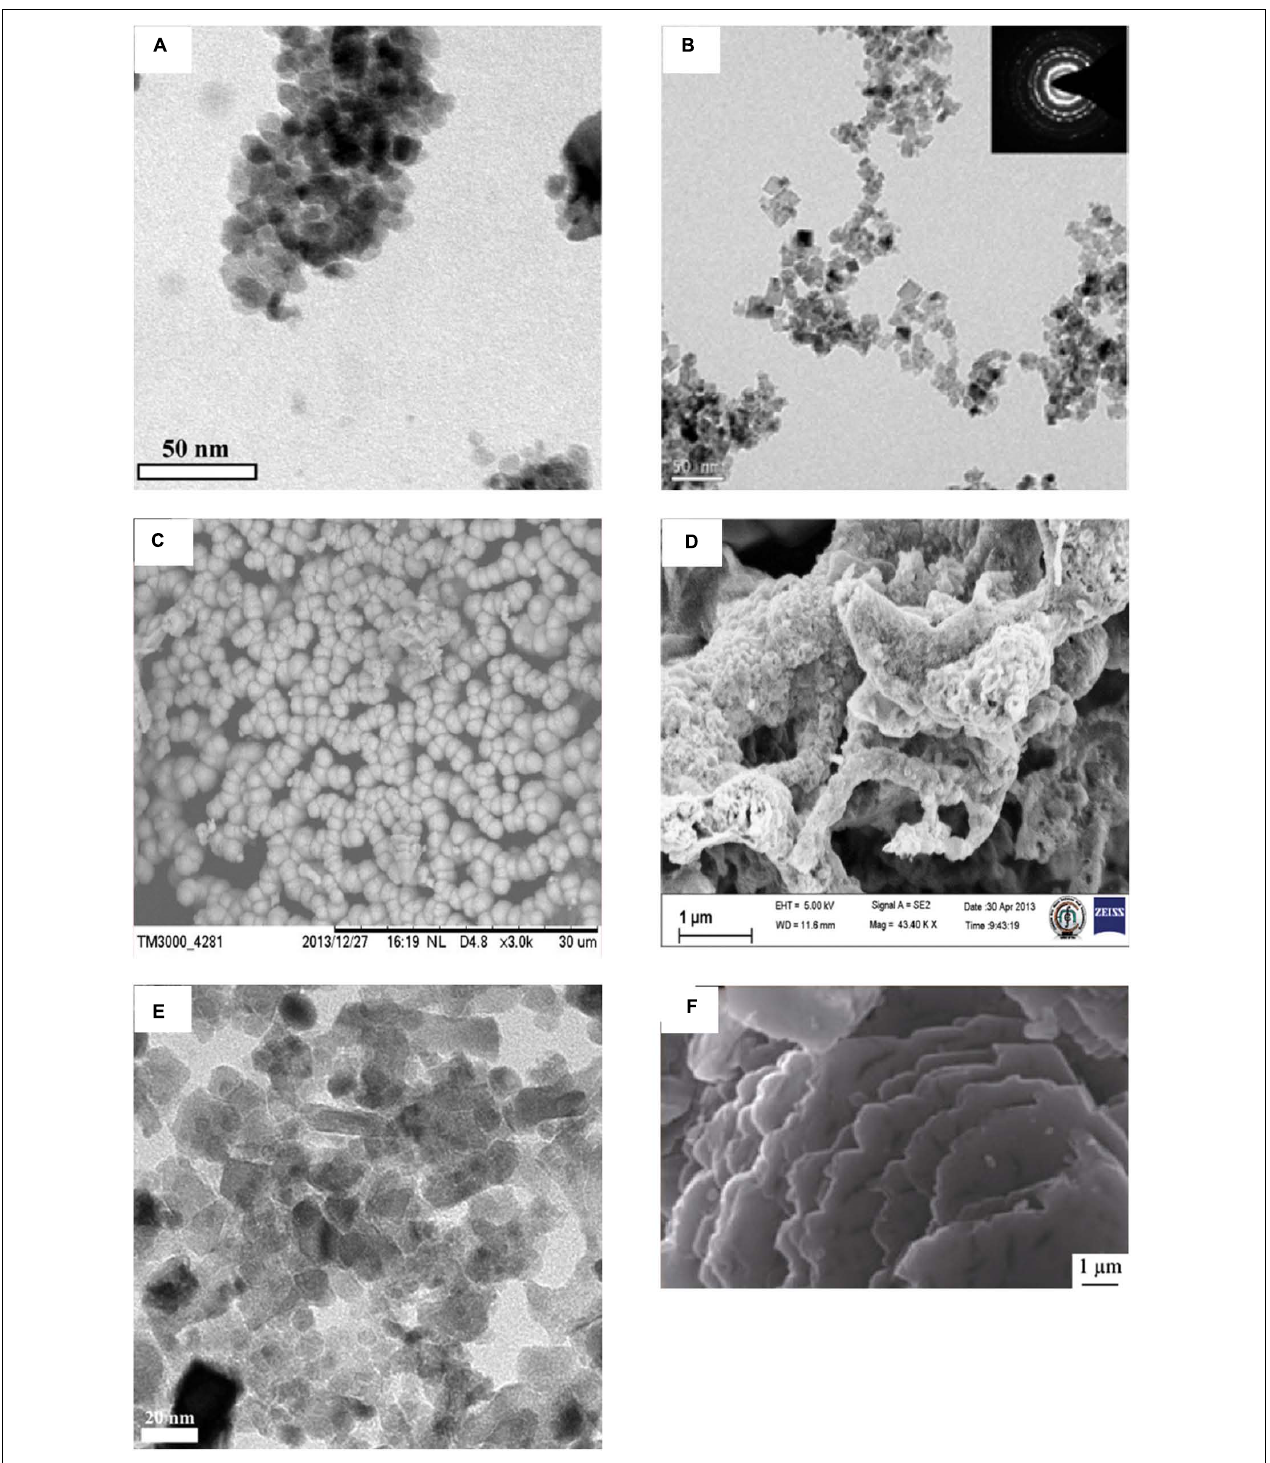
FIGURE 2 | Images of CeO 2 with various morphologies. (A) TEM images of spherical CeO 2 NPs. (B) The high-resolution transmission electron micrograph of CeO 2 nanocubes. The inset in (B) shows the corresponding SAED pattern. (C) SEM micrographs of microsphere CeO 2 NPs. (D) SEM images of irregular CeO 2 NPs. (E) TEM images of cubic and spherical mycosynthesized CeO 2 NPs calcinated at 400 ◦ C. (F) SEM images of prepared CeO 2 nanosheets. Reprinted with permission from Arumugam et al. (2015), copyright 2015 Elsevier, for panel A ; Krishnamoorthy et al. (2014), copyright 2014 Elsevier, for panel B ; Malleshappa et al.